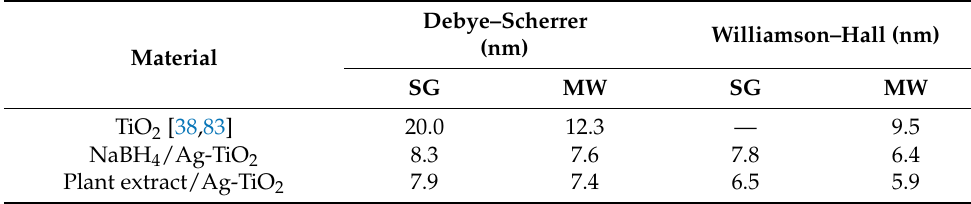
Table 3. Ag-TiO 2 Crystallite size.